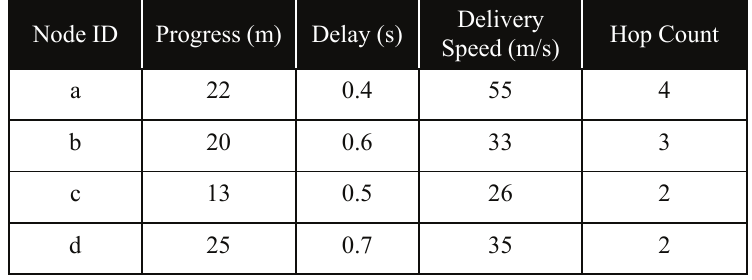
Figure 2. An example of parent election through Desired Delivery Speed